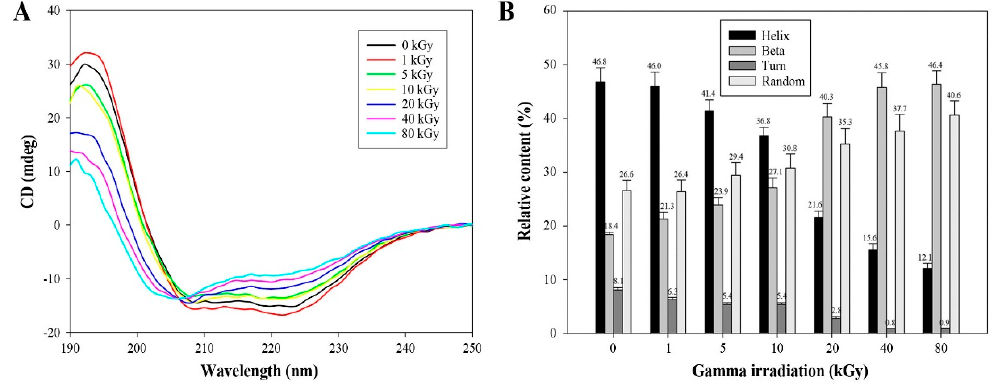
Figure 5. Change in the secondary structure of AtTDX by γ -irradiation. ( A ) Far-UV CD spectra of non-irradiated or irradiated AtTDX proteins in 10 mM Tris-HCl (pH 7.4) buffer. The ellipticity of the CD spectra was expressed in millidegrees (mdeg); ( B ) The comparison of the secondary structure index values (%) was based on the far UV-CD spectra results of AtTDX under different γ -irradiation doses. Data are the means of at least three independent experiments.